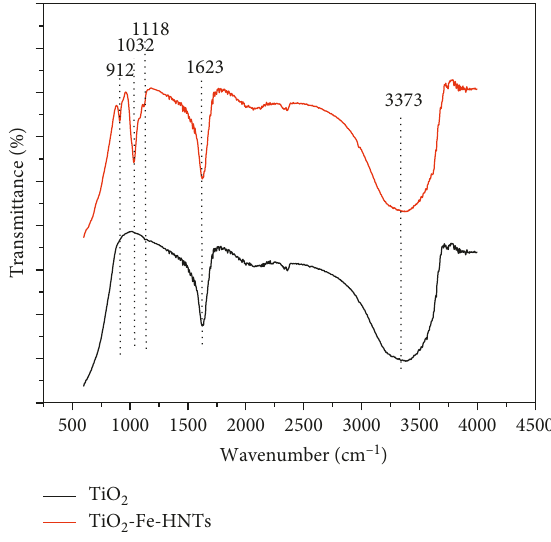
Figure 6: FTIR spectra of TiO